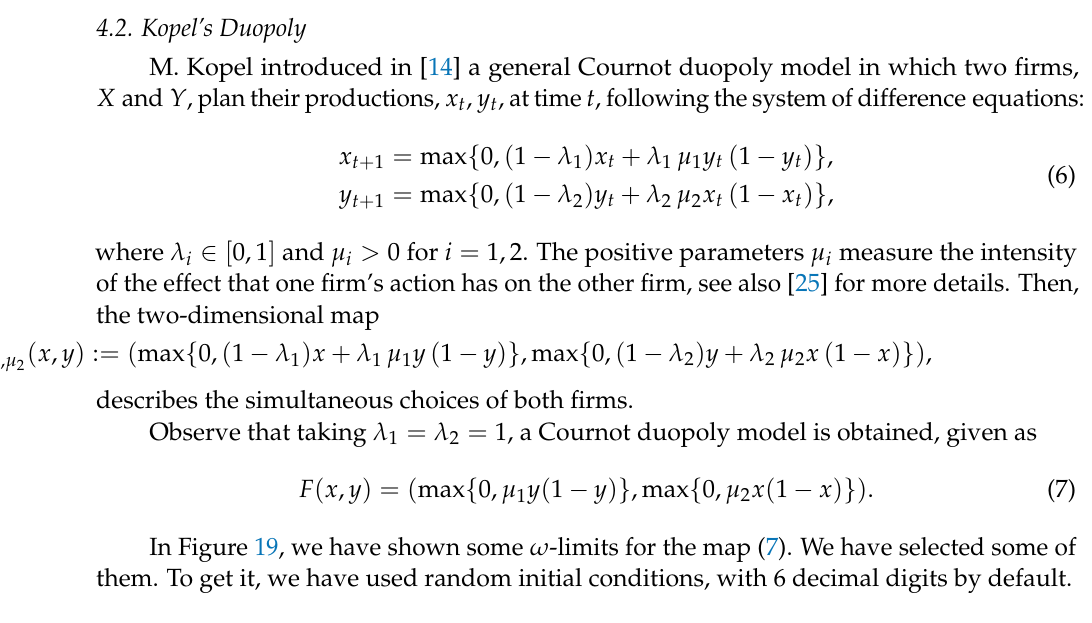
Figure 23. ω -limit sets with empty interior for µ = 1.56, x 0 = − 0.5 and y 0 = − 0.895647 ( left ); µ = 1.58, x 0 = − 0.5 and y 0 = − 0.911129 ( center ); µ = 1.66, x 0 = − 0.5 and y 0 = − 0.973056 ( right